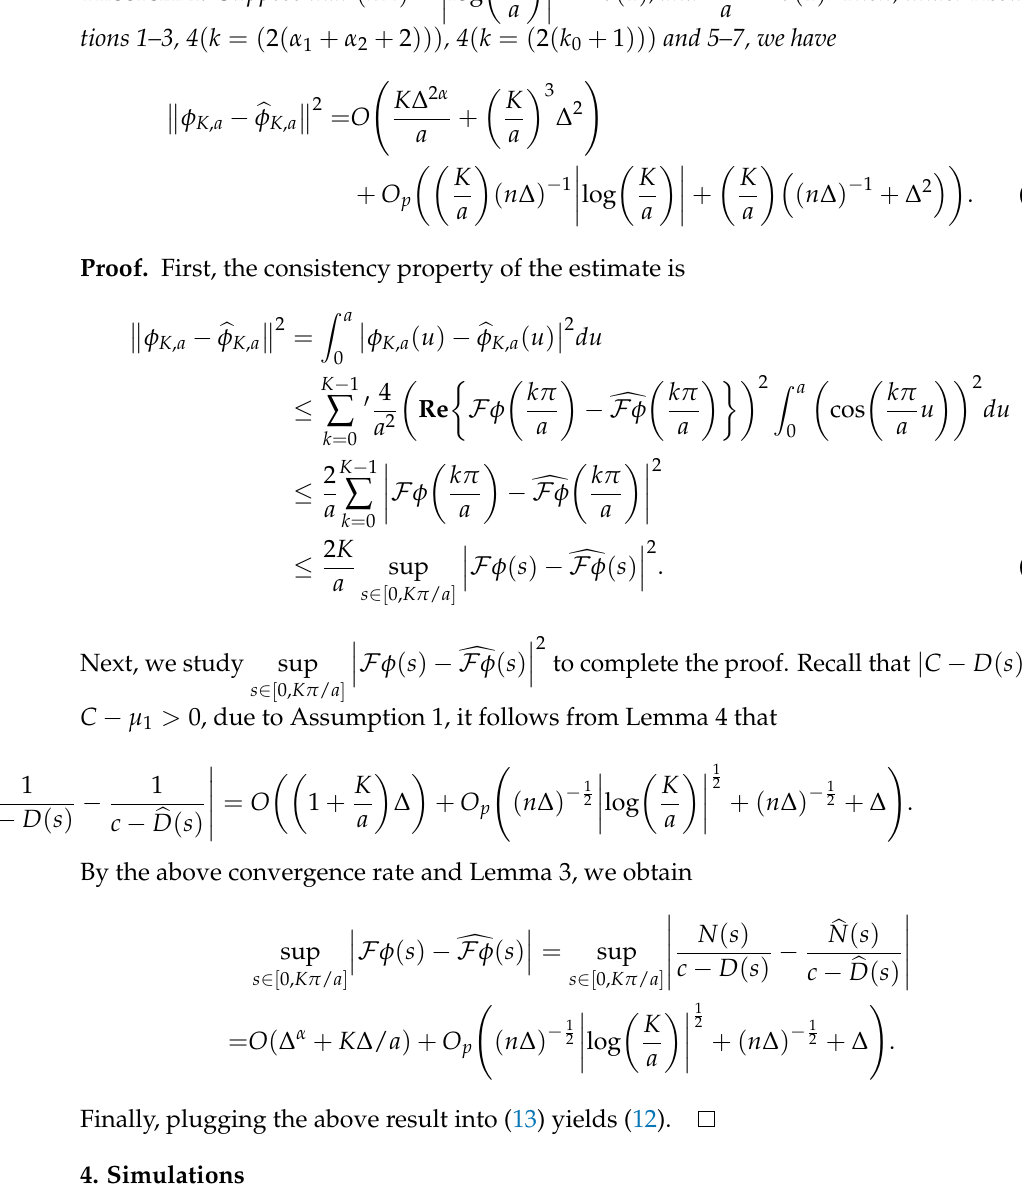
distributed jumps with mean µ =